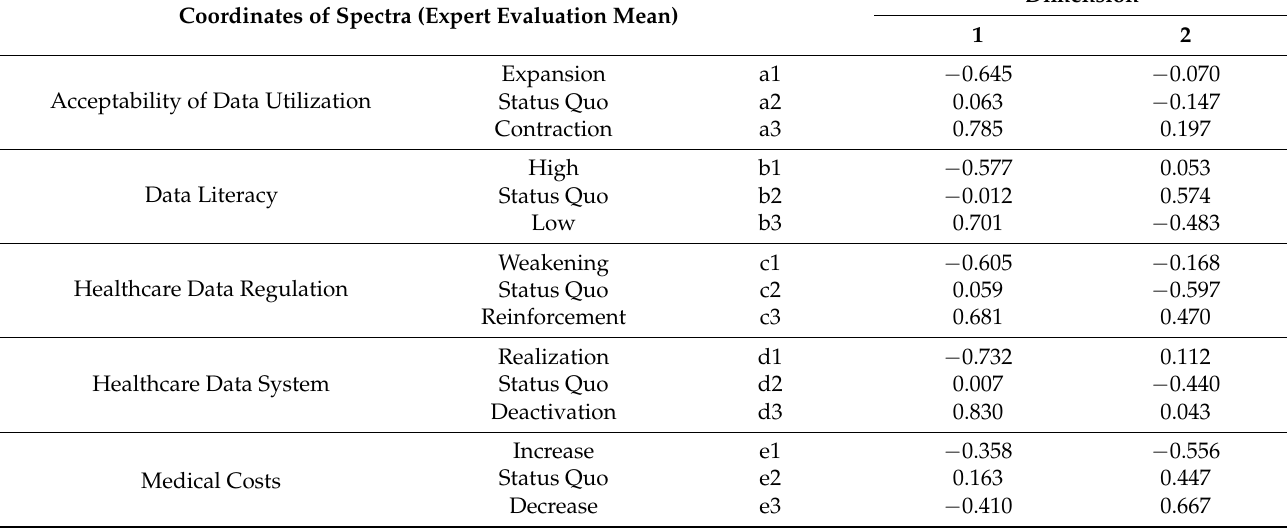
Table 4. Coordinates of spectra (expert evaluation